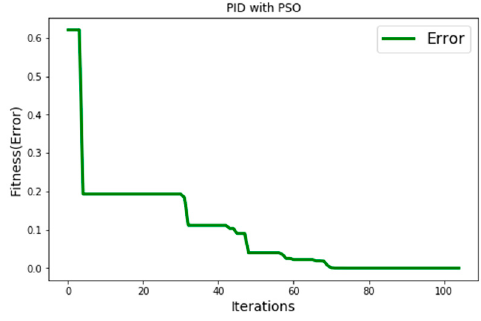
Figure 5. Response of the error with PSO.